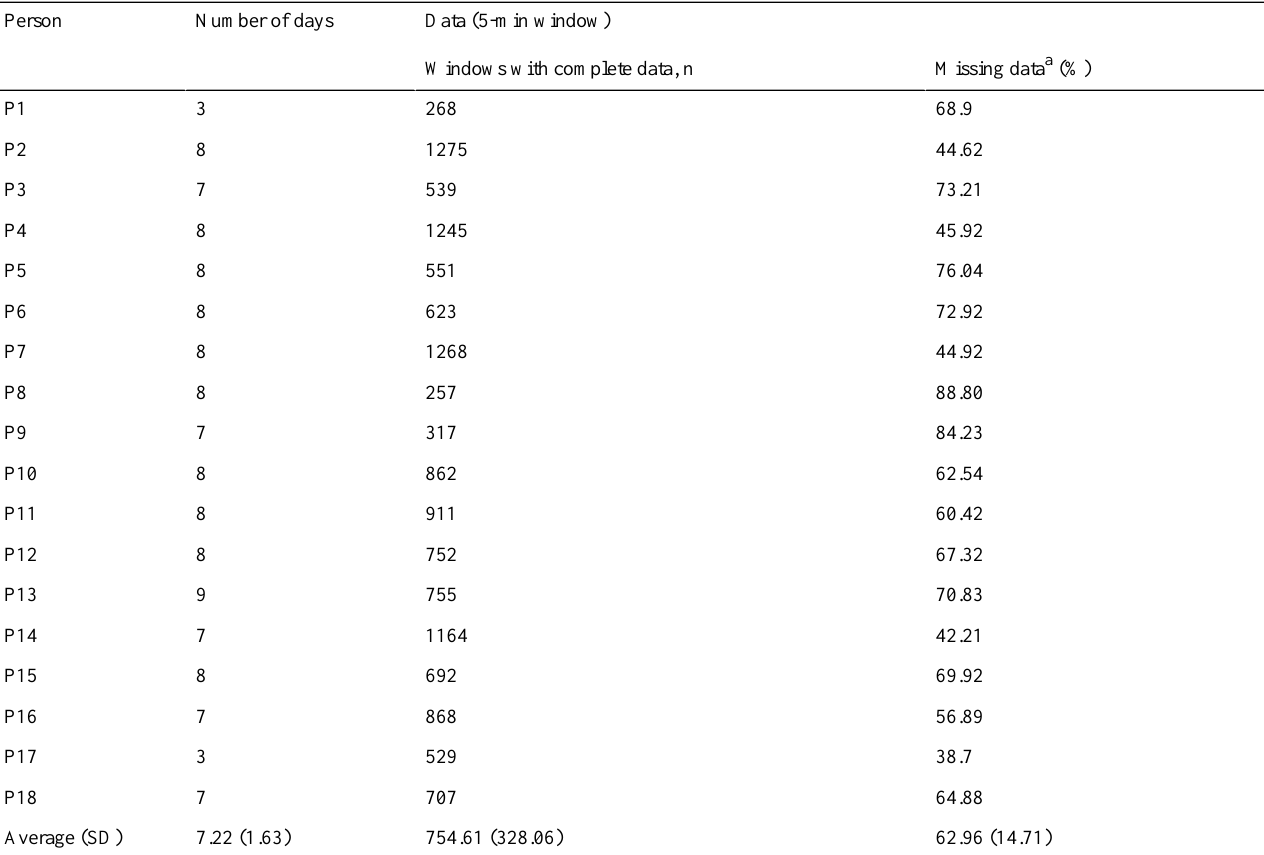
Table 1. Summary of the 18 persons’(P1-P18) data used in this study.